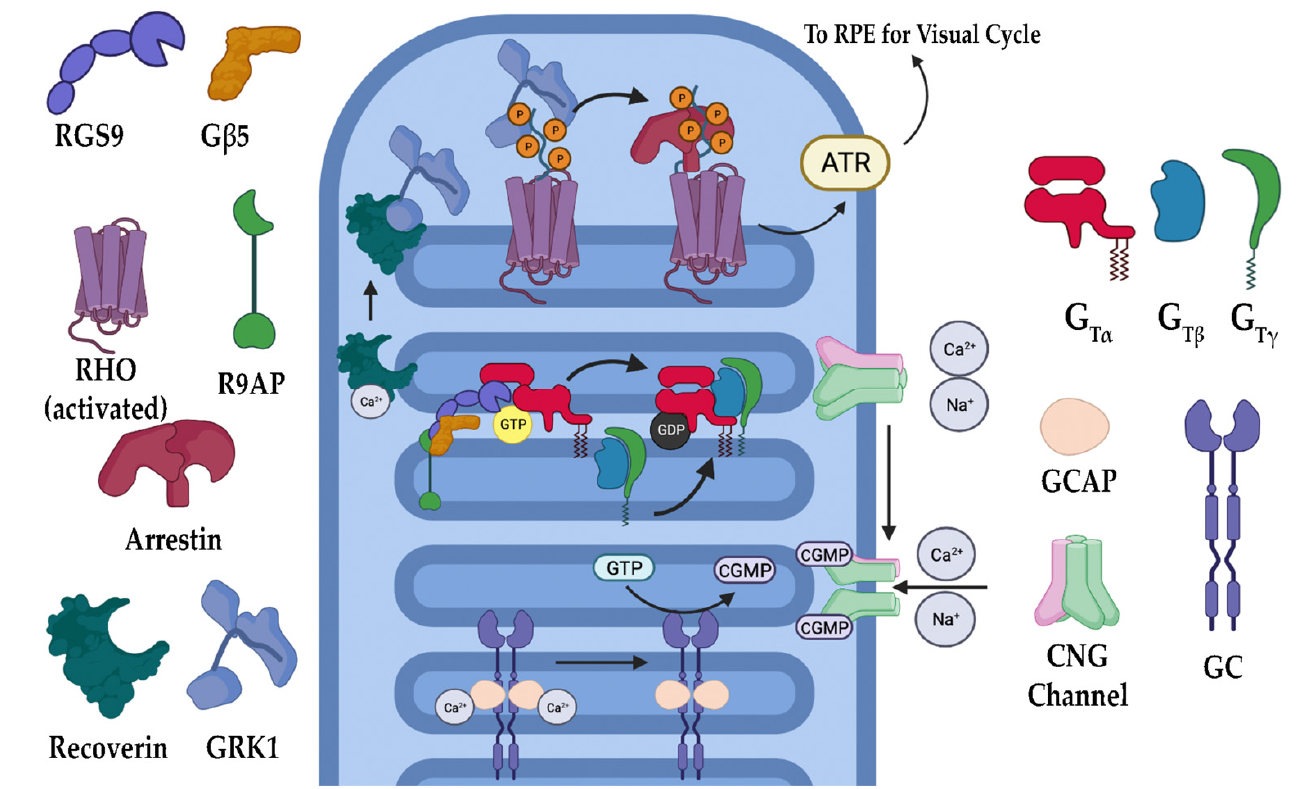
Figure 3. Diagram of phototransduction inactivation pathway proteins. After RHO activation and the subsequent cascade, the resulting decrease in calcium due to CNG channel closure releases the inhibition of recoverin, allowing for it to interact with and activate GRK1. GRK1 then phosphorylates RHO on its carboxyl terminus up to 6 times on serine and threonine residues, inducing RHO capping by arrestin. The isomerized all- trans retinal chromophore (ATR) is then hydrolyzed from the opsin protein and sent to the RPE for cis isomerization. G T has an intrinsic GTPase activity that is further enhanced by the trio of RGS9, G β 5, and R9AP causing hydrolysis of the γ phosphate of GTP forming GDP and inactivating G T α , allowing for the β and γ subunits to reassociate with the α subunit. Along with recoverin, decreased calcium levels from CNG channel closure also release inhibition on GCAPs, allowing for them to activate GCs to produce cGMP from GTP for reopening of the CNG channels and depolarization of the cell to the dark state.